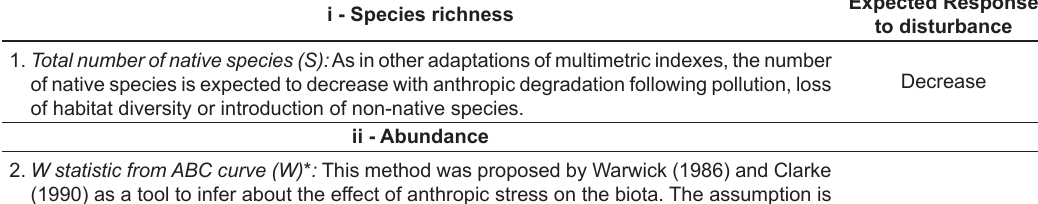
Table 1. Description of the candidate metrics and their expected behavior in response to